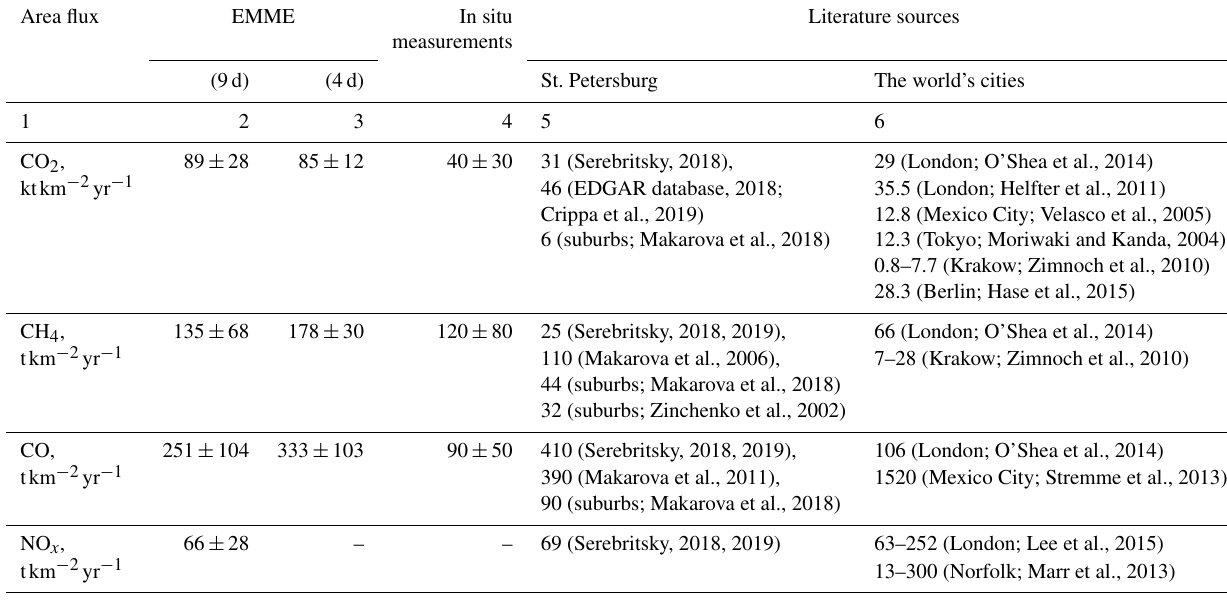
Figure 7. Time series of the CO 2 TC measurements by mobile FTSs at upwind (U, blue) and downwind (D, red) locations on 2d, (a) 4 and (b) 25 April 2019. The measurements are compared with the results of the HYSPLIT simulations at both locations, upwind and downwind. For the day of 25 April, a special HYSPLIT scenario is added for comparison: the emission of the major thermal power station (TPS) of St. Petersburg nearby the upwind FTS location is turned off (“no TPS”; see Fig. 8 and the text for details). Table 1. Area fluxes for CO 2 (ktkm − 2 yr − 1 ), CH 4 (tkm − 2 yr − 1 ), CO (tkm − 2 yr − 1 ) and NO x (tkm − 2 yr − 1 ) obtained during EMME-2019 and the flux estimates for St. Petersburg based on in situ measurements. The values previously reported in literature are also